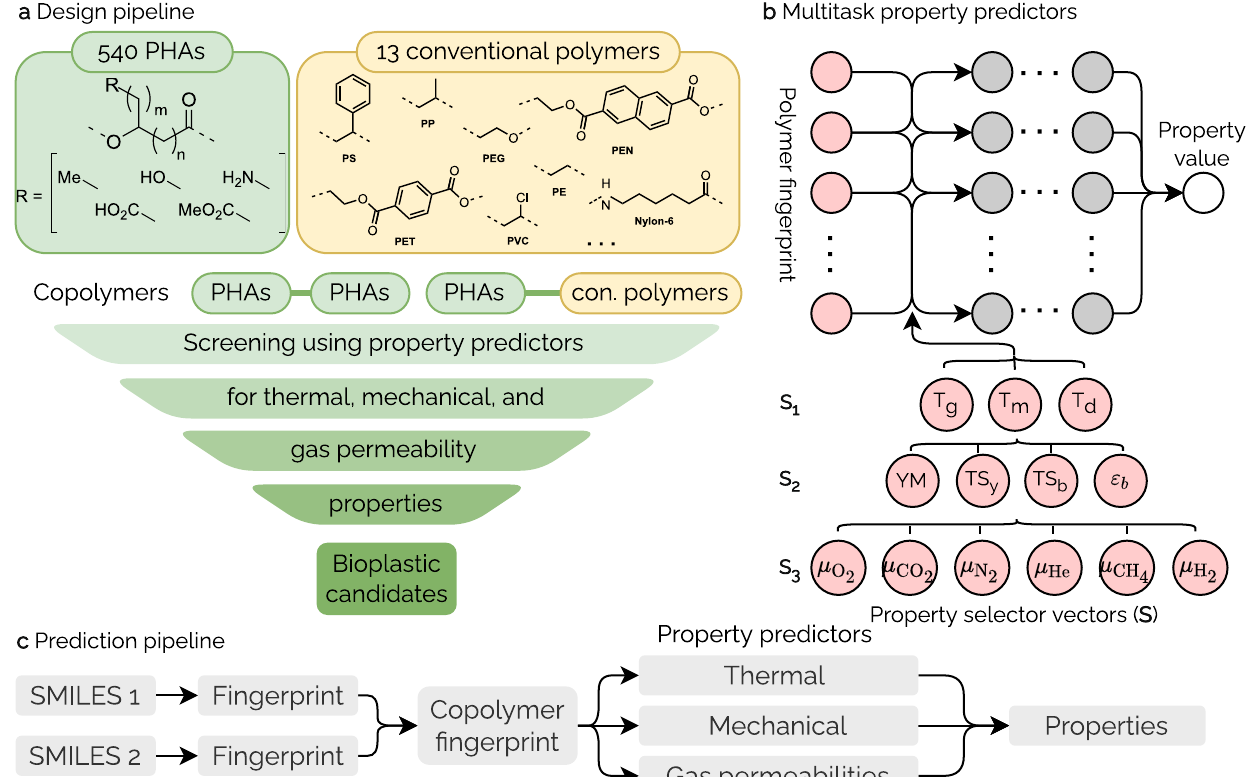
Fig. 1 Bioplastic design using multitask deep learning predictors. a Design pipeline. A large search space is created by combining 540 polyhydroxyalkanoates (PHAs) and 13 conventional polymers to copolymers. Property predictors and property requirements of commonly used polymers allow us to identify bioplastic candidates within the search space. b Architecture of the multitask neural network predictors. Three separate predictors are trained; one for each of the selector vectors ( S 1 , S 2 , S 3 ). S is a binary vector (1 for the selected component and 0 everywhere else) that selects the output property. c Prediction pipeline. The two SMILES 58 strings belong to comonomers in a